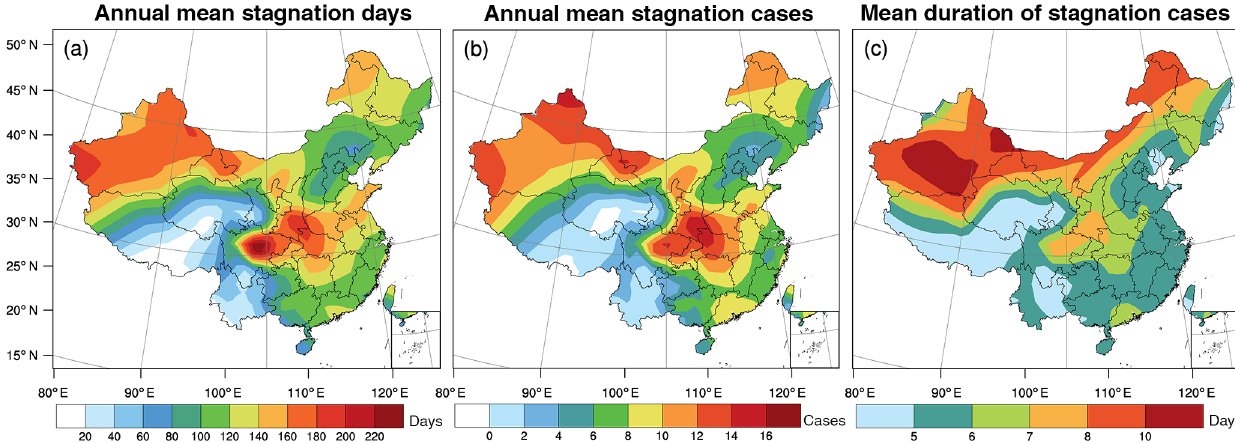
Figure 9. The spatial distribution of annual mean stagnation days (a) , stagnation cases (b) , and duration of stagnation cases (c) under new metrics.